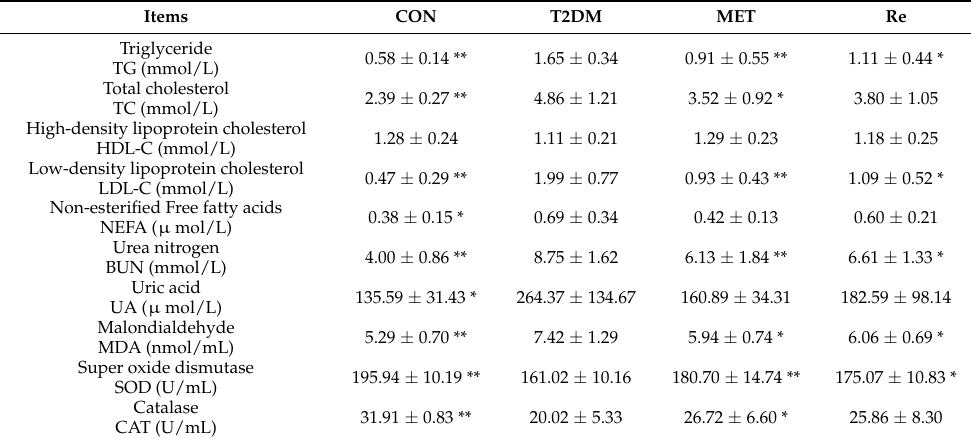
Table 1. Biochemical parameters of rats in different groups after treatment for 30 days.